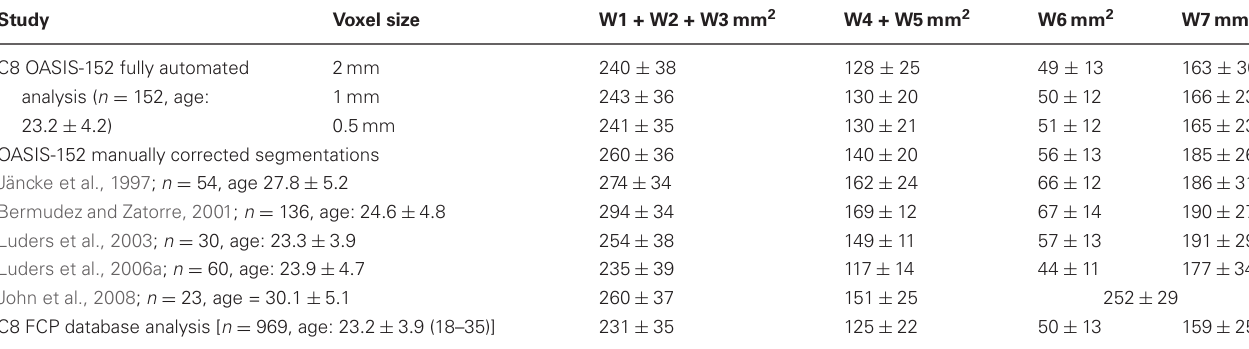
Table 1 | Corpus callosum area measurements (mean and standard deviations) for callosal Witelson (W) compartments (see Figure 3A) obtained from the OASIS-152 anatomical image database (Marcus et al., 2007) using the present